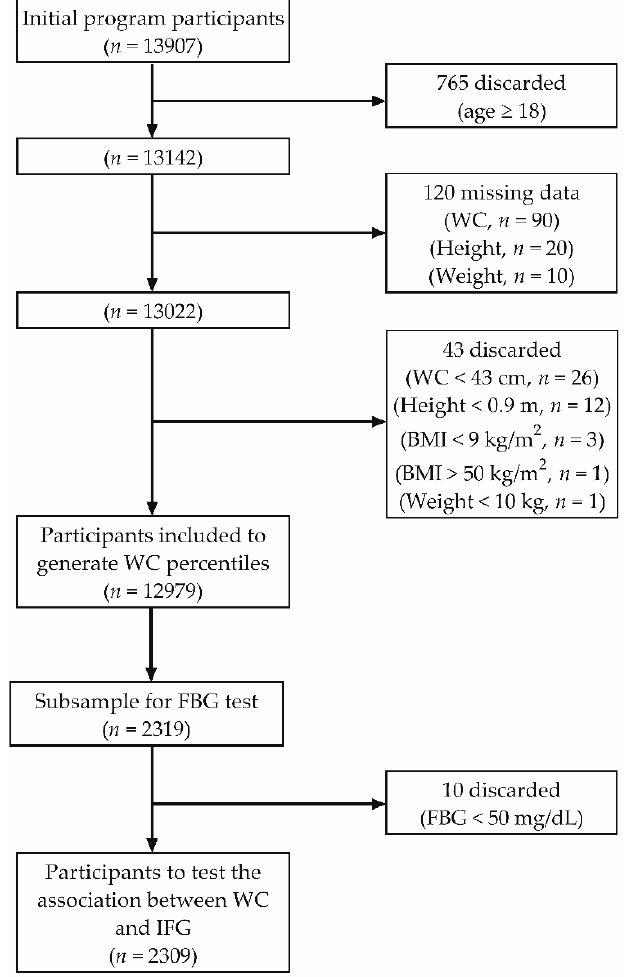
Figure 1. Participants flowchart. BMI: Body mass index; FBG: Fasting blood glucose; IFG: Impaired fasting blood glucose; WC: Waist circumference.